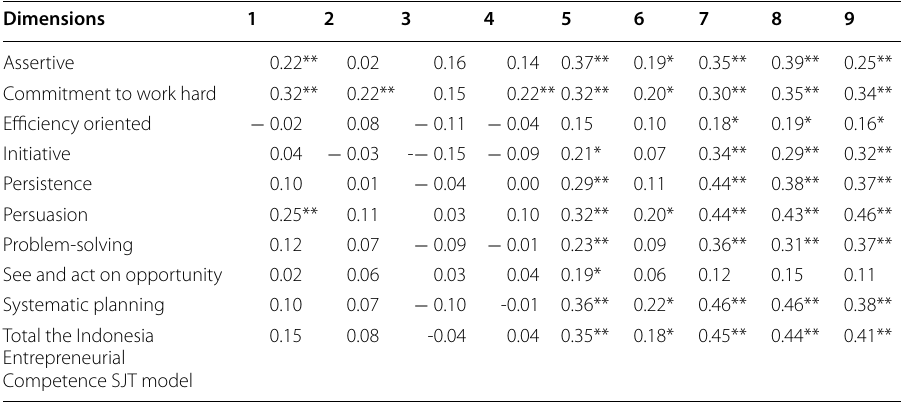
1. Ability to see opportunity; 2. Ability to think strategically; 3. Ability on business management; 4. Total Entrepreneurial Competence; 5. Risk Decision Making; 6. Courage to act; 7. Able to take risk; 8. Total Risk Taking behaviour; 9. Business Success. * p < 0.05; ** p <